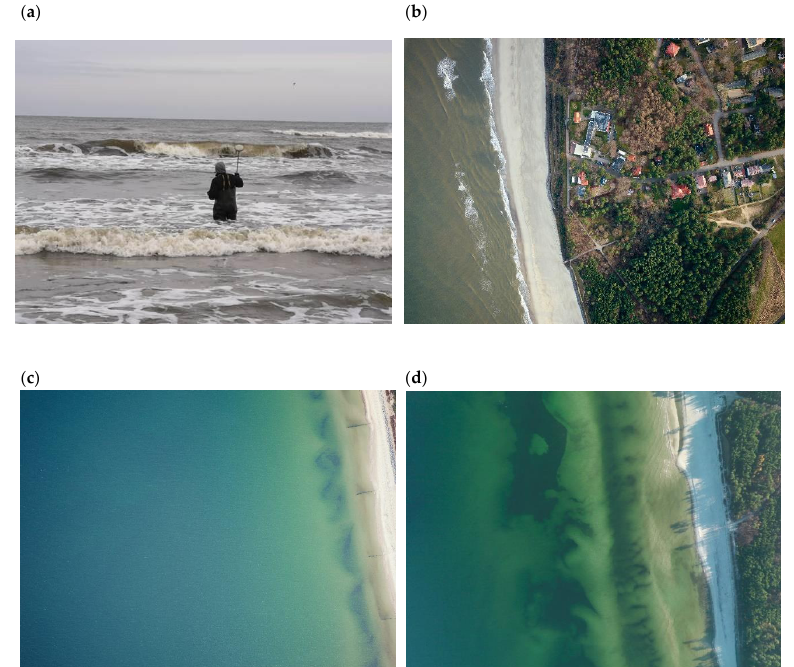
Figure 3. Representation of Red–Green–Blue (RGB) images specifying the bathymetric scanning conditions on a five-point scale: ( a ) 1–2, cloud cover and large waves make topographic–bathymetric measurements unfeasible; ( b ) 2–3, increased sea level and high silting make